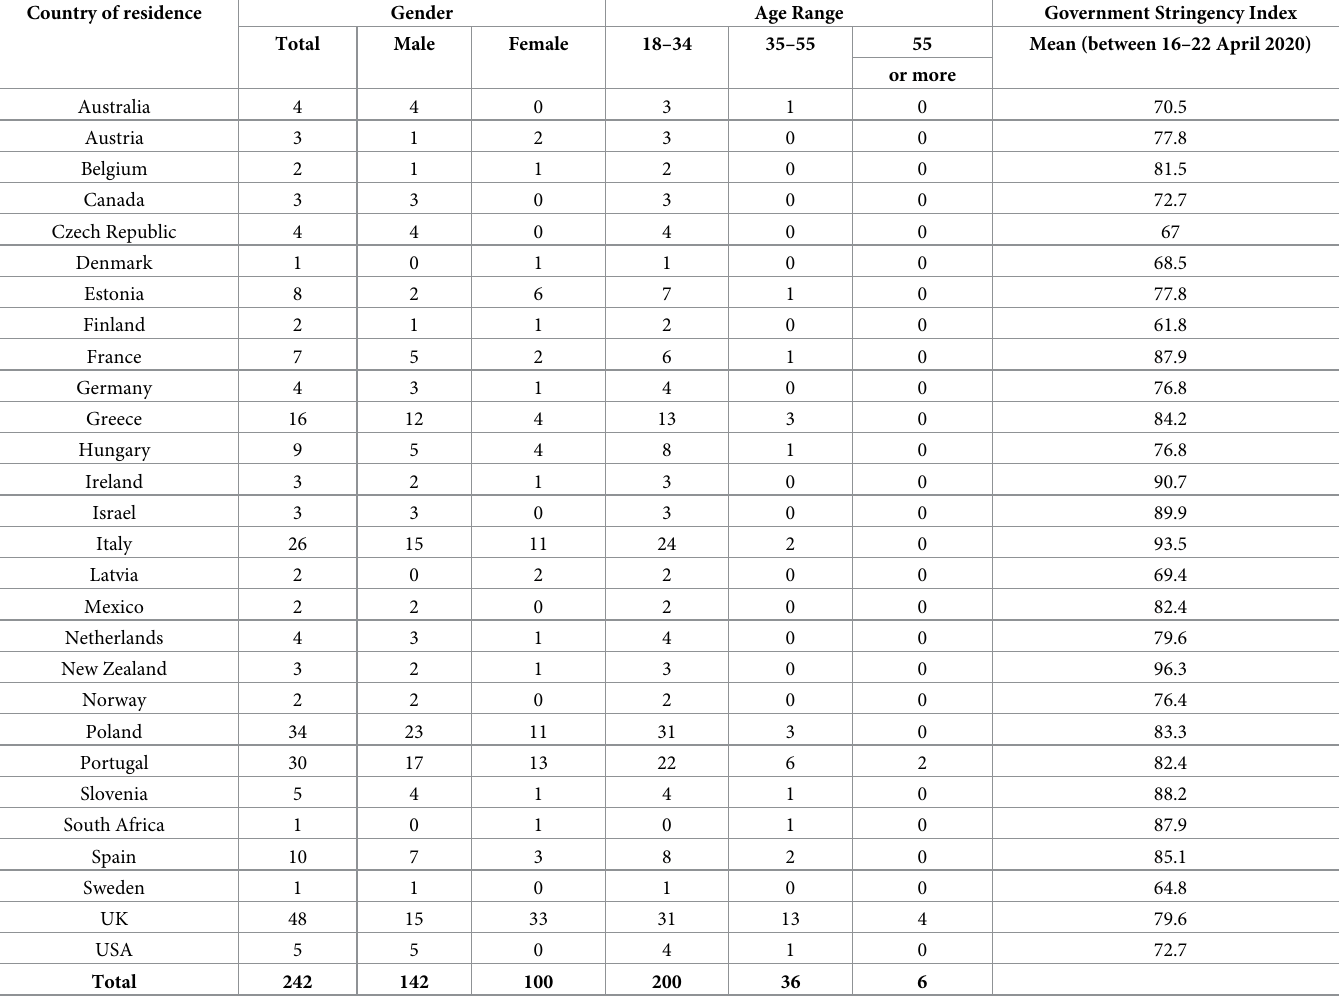
Table 1. Demographic characteristics for each of the 28 countries of residence included in the